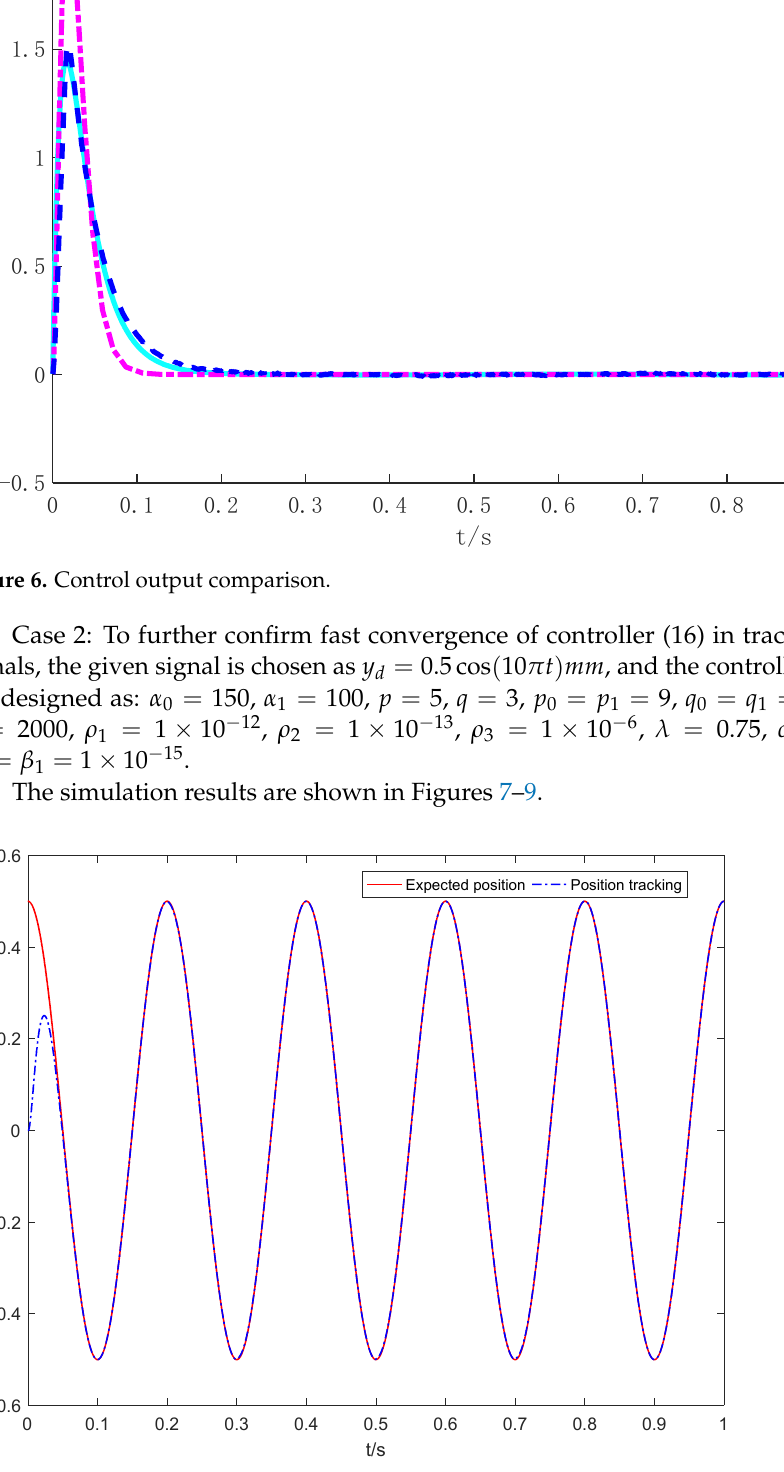
Figure 7. Position tracking curve under dynamic signal.